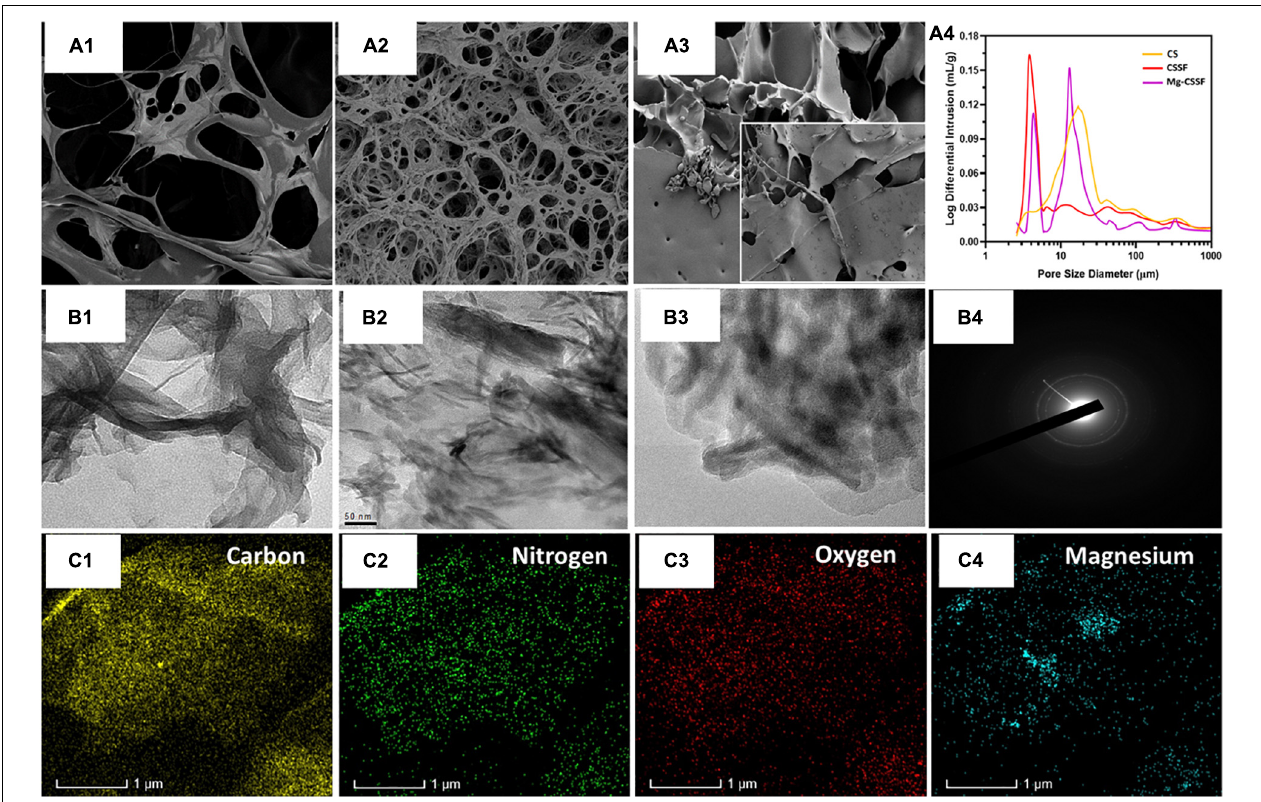
FIGURE 3 | Morphological structure, porous network, and component distributions were investigated and presented using scanning electron microscope (SEM) and transmission electron microscope (TEM) microscopic instruments and EDX mapping results; (A 1 − 3 ) are the SEM observations of the CS, magnesium loaded chitosan/silk fibroin (Mg/CSSF) and, Mg/CSSF hydrogel groups, respectively, which exhibit improved porous morphology consistent with the pore size analysis results (A 4 ) . Transmission microscopic observations of hydrogel groups are displayed as (B 1 ) CS, (B 2 ) Mg/CSSF, (B 3 ) Mg/CSSF, and (B 4 ) SAED patterns of Mg/CSSF. (C) Elemental distributions of C, O, N, and Mg elements were confirmed by EDX mapping